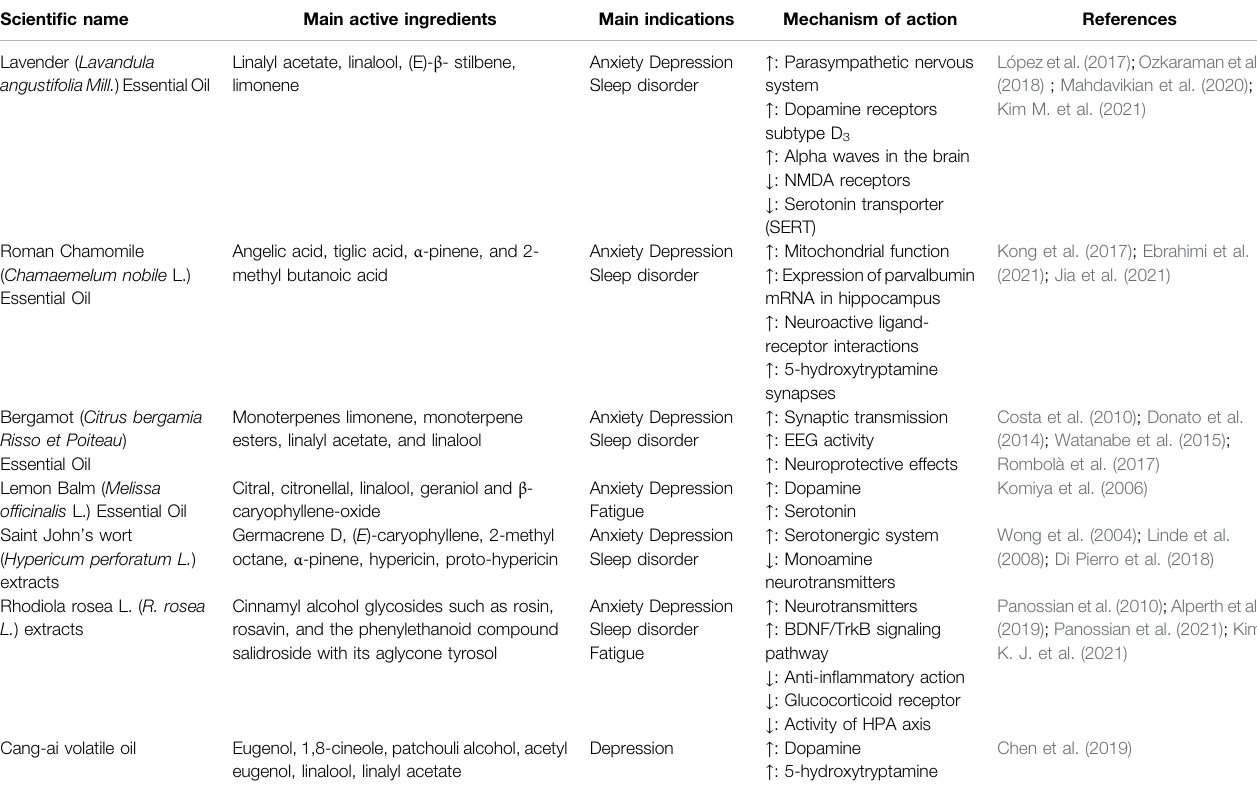
TABLE 1 | Use of aromatic plants ’ volatiles or essential oils to treat neuropsychiatric